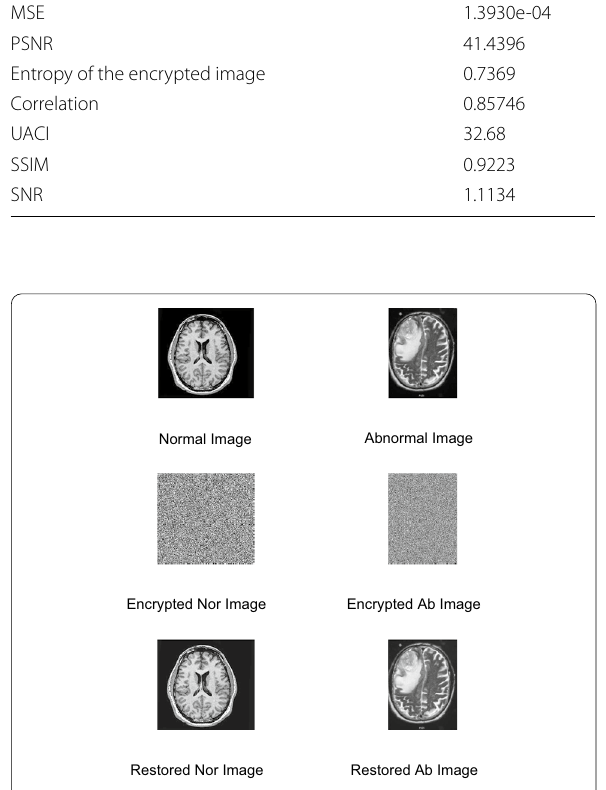
Fig. 4 Normal and abnormal brain images after and